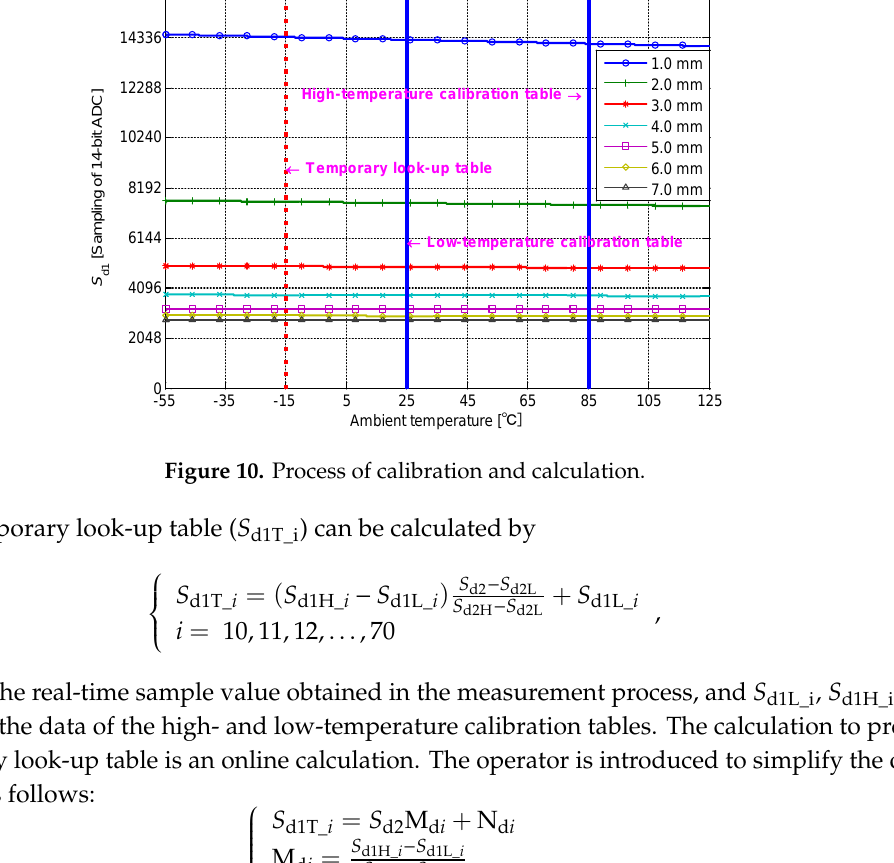
tableHigh-temperature calibration table →